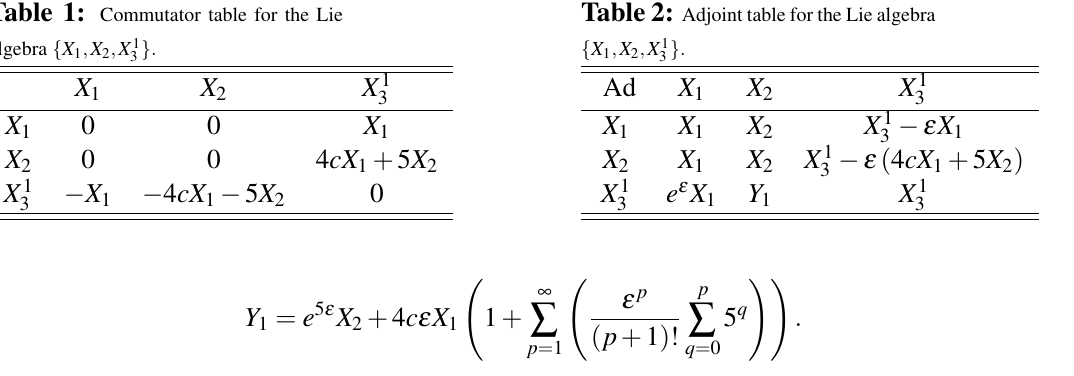
Table 1: Commutator table for the Lie algebra { X 1 , X 2 , X 1 3 } .